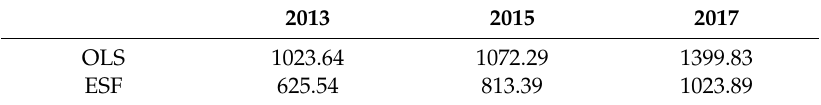
Table 11. Leave-one-out cross validation (LOOCV) RMSE of the OLS and ESF regression models.